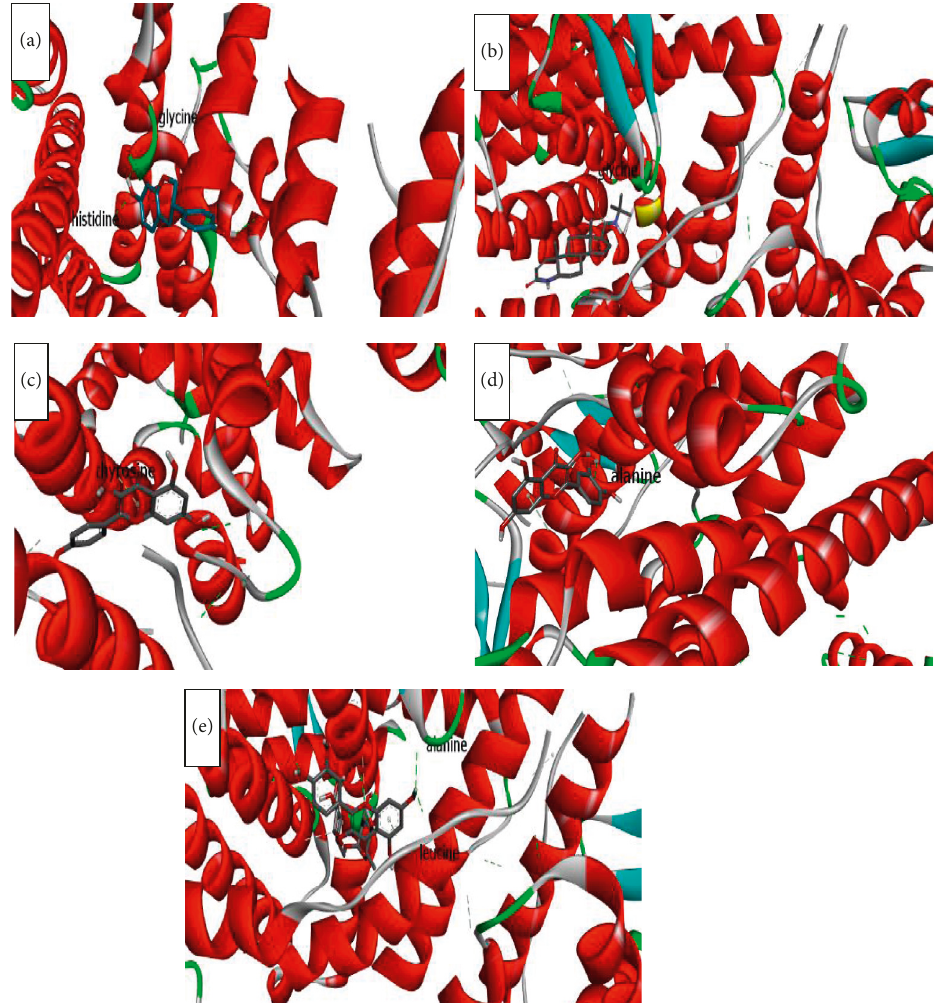
Figure 7: Interaction between amino acids in the binding site of ER-a enzyme, and (a) � equol, (b) � finasteride, (c) � kaempferol, (d) � quercetin, and (e) � rutin, respectively. The green bonds show intramolecular hydrogen bonds. Glycine, histidine, tyrosine, alanine, and leucine from ER-a enzyme are involved in H-bond interaction with